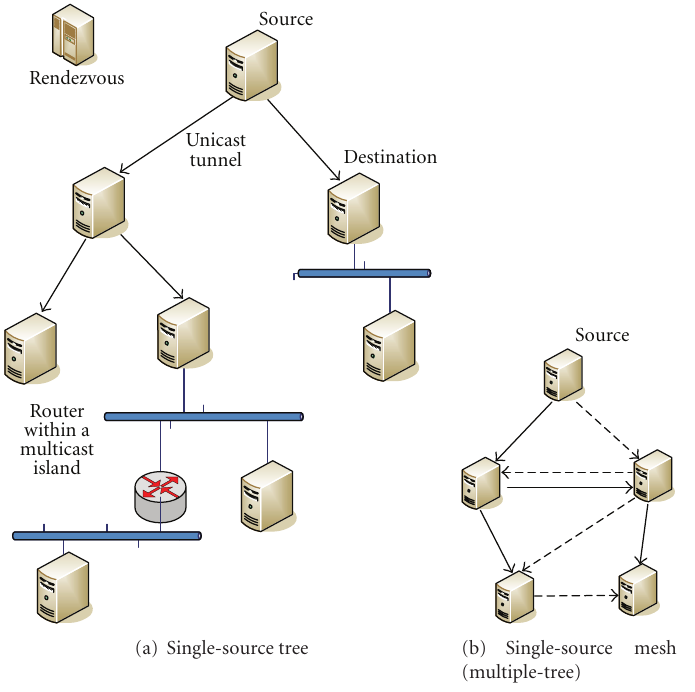
Figure 1: P2P IPTV structure of tree and